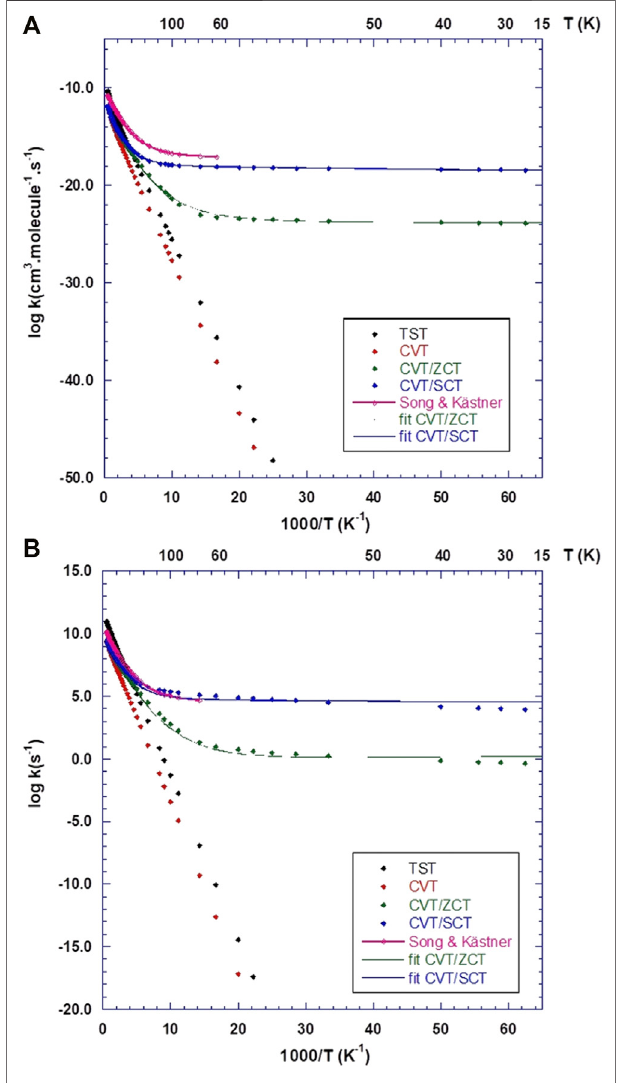
FIGURE 7 | Calculated rate constants using CBS/DLPNO-CCSD(T)// ONIOM(M05-2X:Amber) results, compared to the analytical functions provided by Song and Kästner (2017). (A) Eley-Rideal (ER) rates. (B) Langmuir-Hinshelwood (LH) rates.